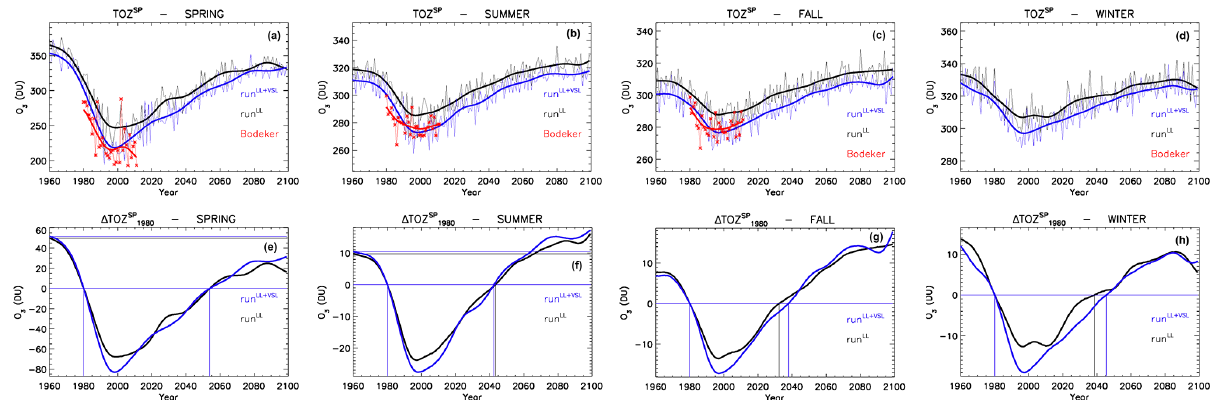
Figure 3. The same as Fig. 2 but computing the average for (a, e) spring (defined as September–October), (b, f) summer (January–February), (c, g) autumn (March–April) and (d, h) winter (June–July). The monthly output for the periods where a strong dynamical transition between seasons exists has not been considered (see text for details).